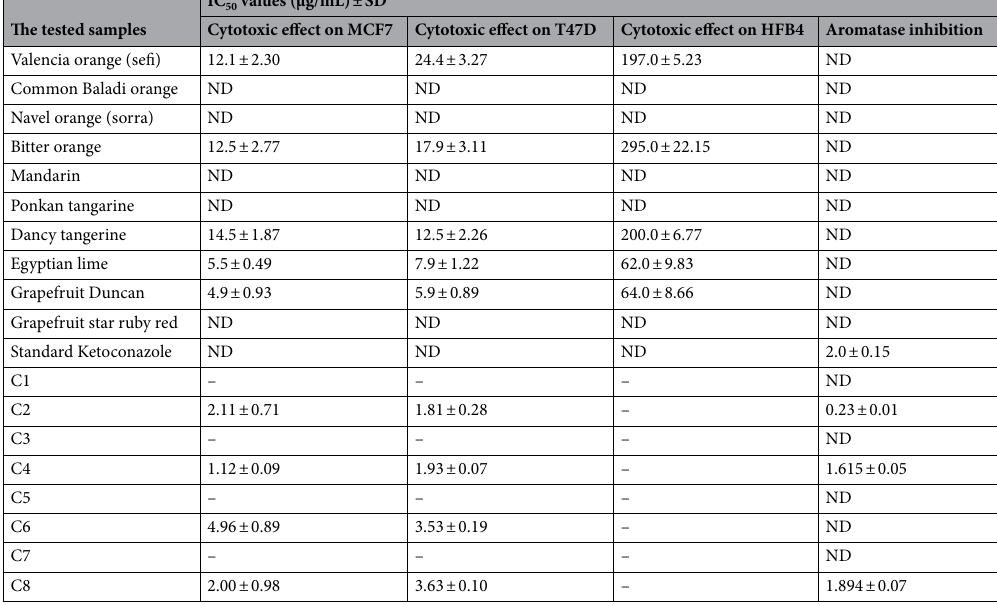
Table 3. In vitro anticancer and anti-aromatase activities of citrus peel extracts and the isolated compounds. ND not done. (−) no activity in a concentration up to 50